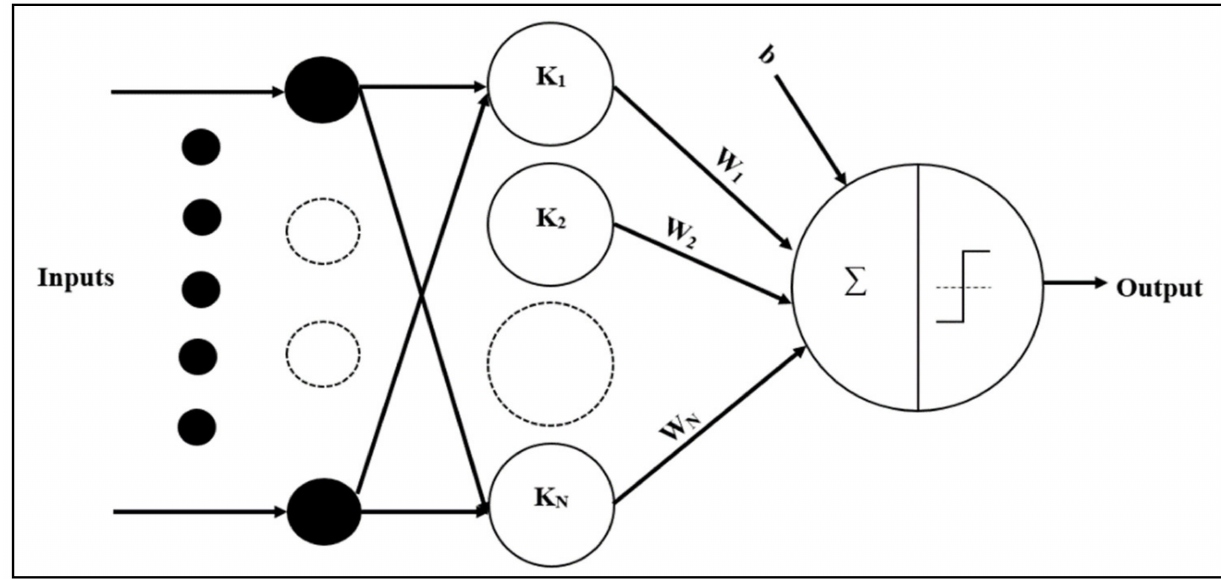
Figure 11. The structure of SVM